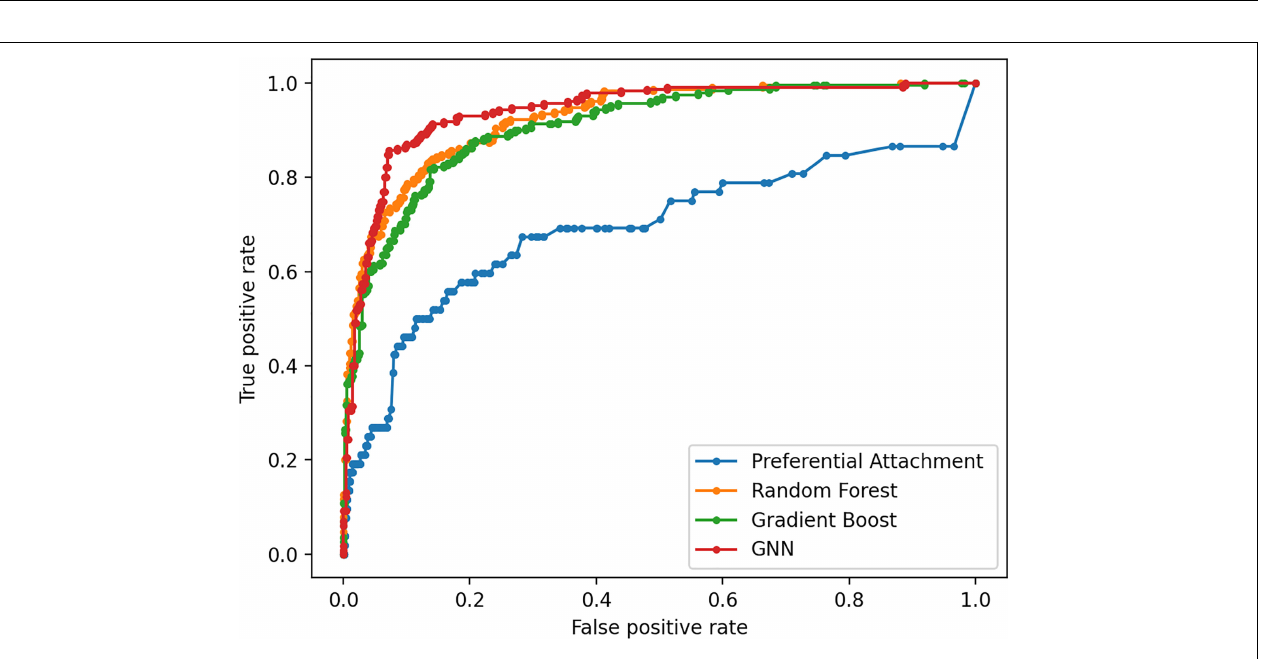
FIGURE 6 | Receiver Operating Characteristic curves for link prediction between muscle atrophy related diseases and drugs used for their treatment in the DDKG using PA, RF, Gboost and GNN methods.